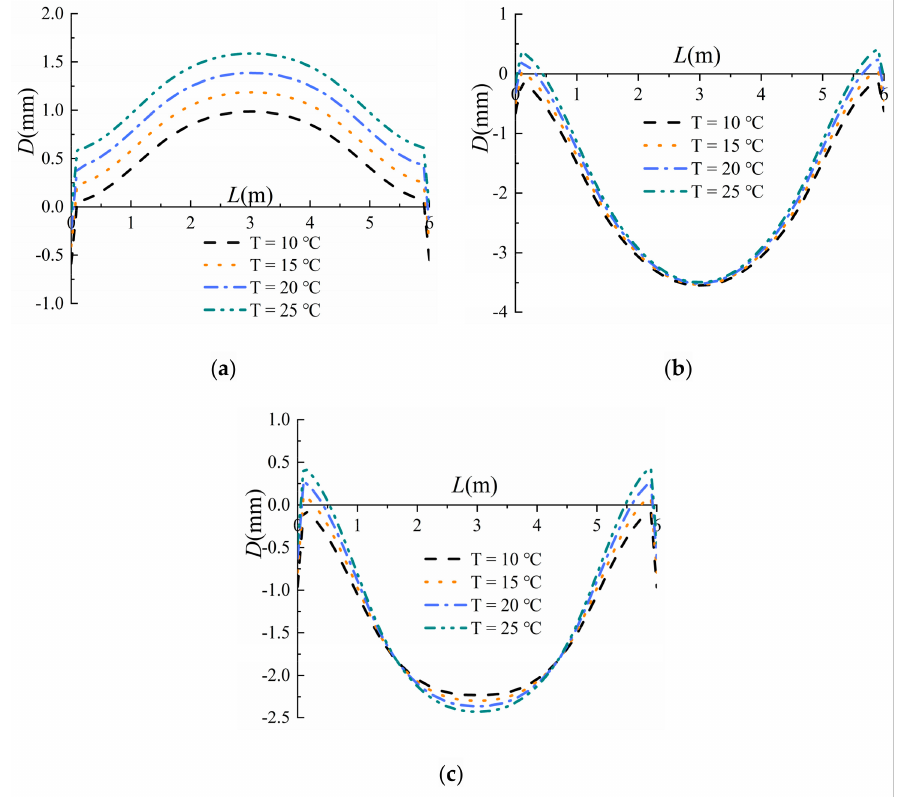
Figure 23. The displacement–temperature relationship of ( a ) the crown beam, ( b ) waist beam 1, and ( c ) waist beam